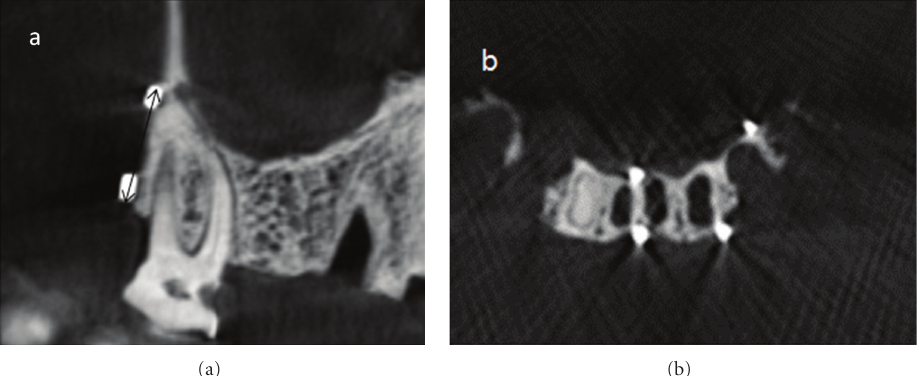
Figure 2: Examples of measured distances in di ff erent views. (a) Height: the arrow shows the measured distance; (b) buccolingual and mesiodistal length.